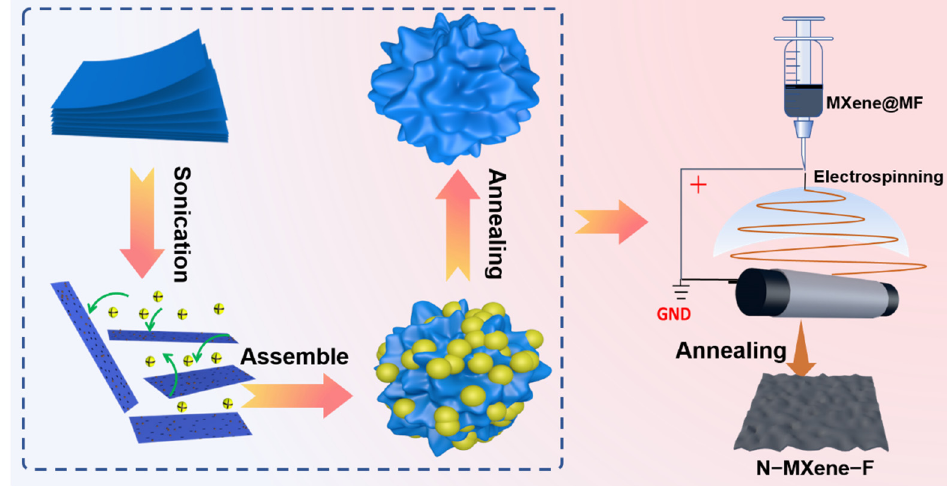
Figure 1. Schematic illustration of the fabrication of the N-MXene and N-MXene-F.